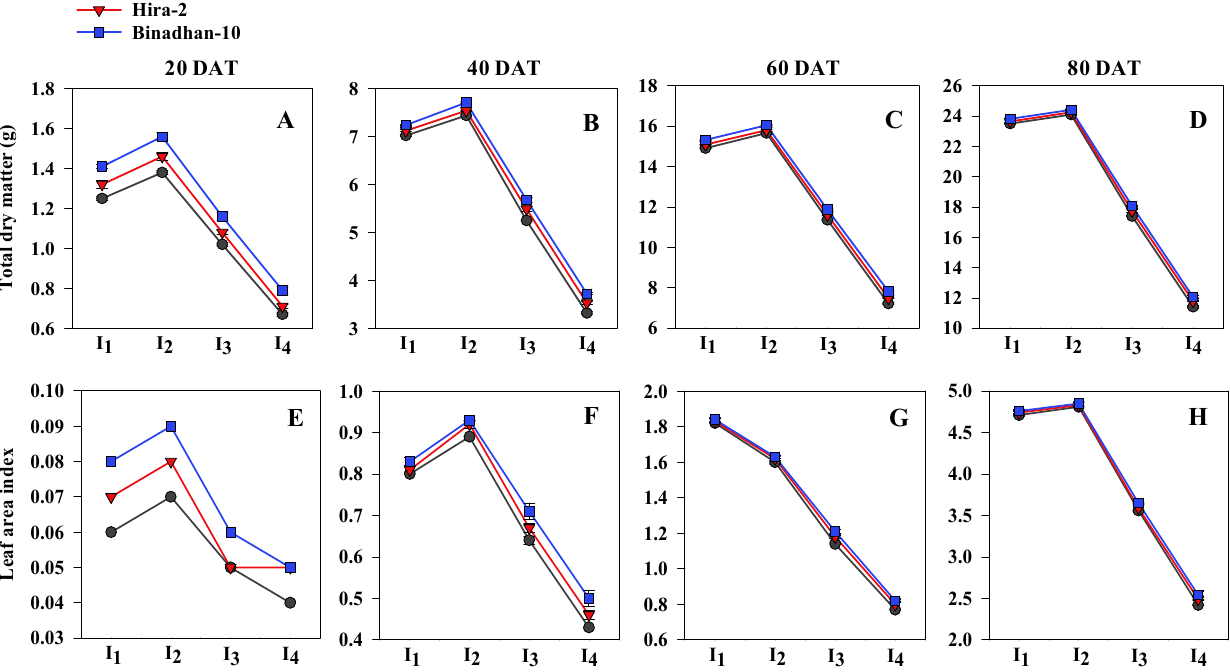
Figure 2. Total dry matter (TDM) and leaf area index (LAI) of three rice cultivars at four irrigation regimes during 20 DAT to 80 DAT. I 1 -Continuous flooding, I 2 -Saturation, I 3 -75% of saturation, I 4- 50% of saturation; ( A – D ) represent TDM; ( E – H ) represent LAI.